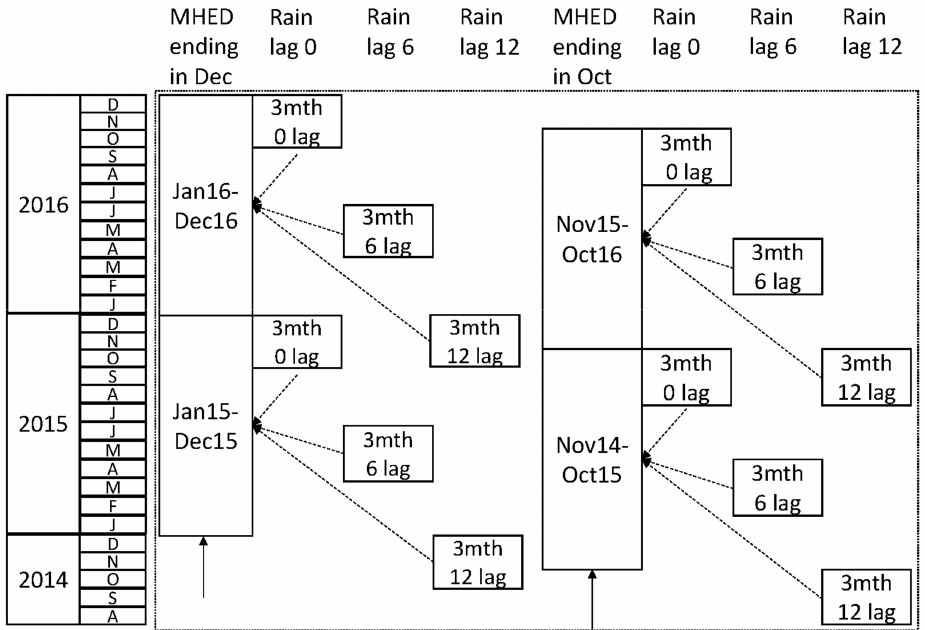
Figure 1. Example temporal arrangements. MHED: mental health-related emergency department; mth: month.